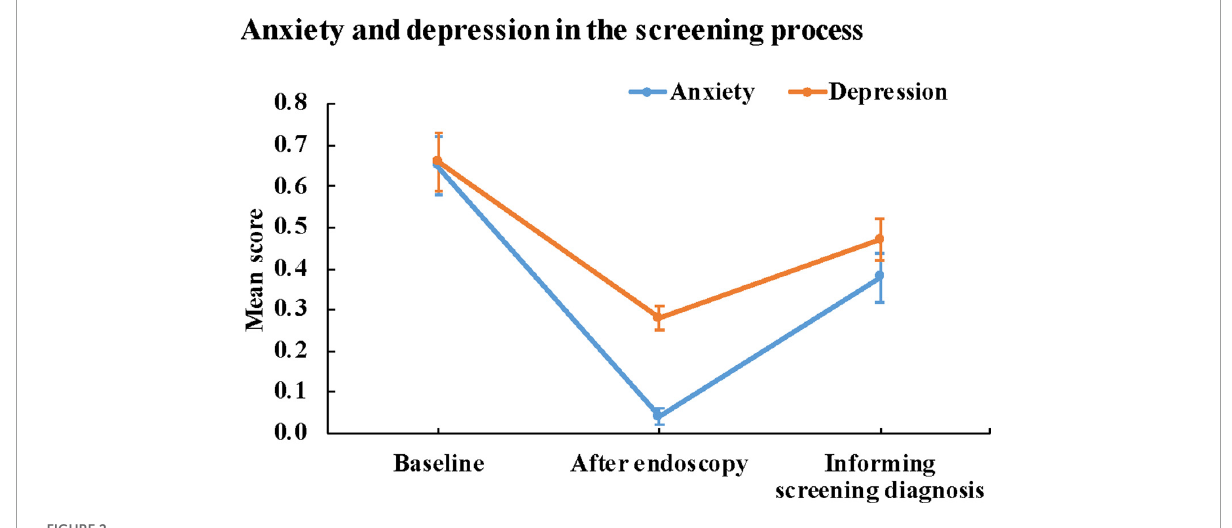
FIGURE2 Anxiety and depression in the screening process.